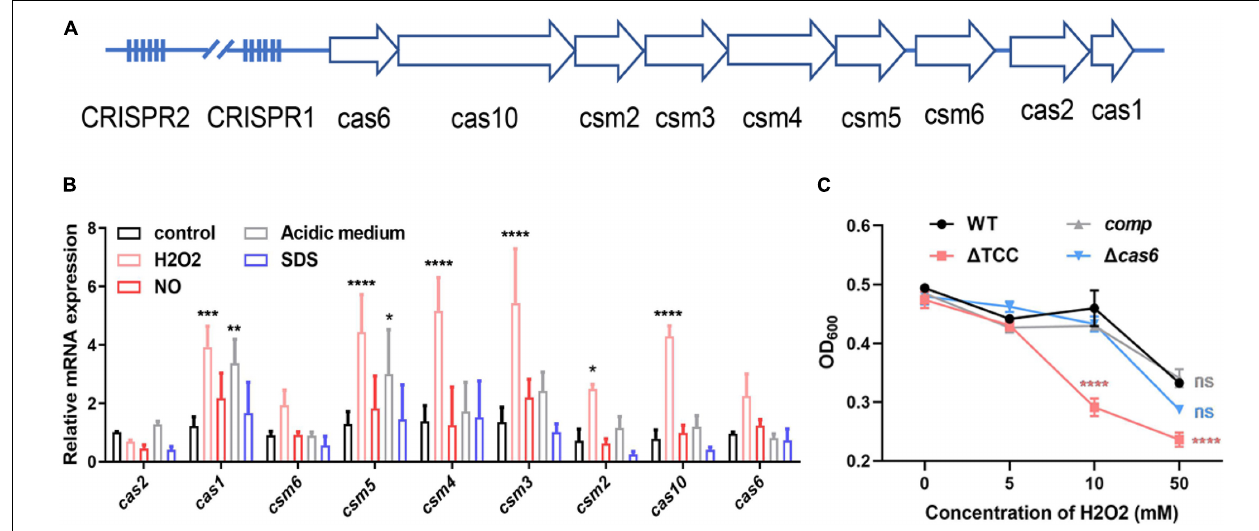
FIGURE 1 | Inactivation of type III-A CRISPR-Cas system decreased bacterial survivability under oxidative stress. (A) Schematic of the Mycobacterium bovis BCG type III-A CRISPR-Cas operon. The type III-A CRISPR-Cas loci comprise csm2-6 , cas10 , cas6 , cas1 , cas2 , and two CRISPR locus. (B) Fold changes in mRNA level of nine cas genes during different stresses. BCG was grown in 7H9 medium containing OADC and Tween 80 to mid-log phase. These strains were treated with different stresses, including 5mM NO, acidic medium (pH4.5), 1% SDS, 5mM H 2 O 2 . The expression of cas genes was analyzed by real time PCR ( n = 3 biological replicates per group, data are shown as the mean ± SEM, two-way ANOVA with Tukey’s multiple comparison test, compared with control group; * p < 0.05, ** p < 0.01, **** p < 0.0001). (C) Differential susceptibility of WT BCG, (cid:49) TCC, comp , or (cid:49) cas6 strains to H 2 O 2 compared to control was determined by OD 600 measurements. M. bovi s BCG were grown in 7H9 medium containing OADC and Tween 80 to mid-log phase. The cultures were treated with different amounts of H